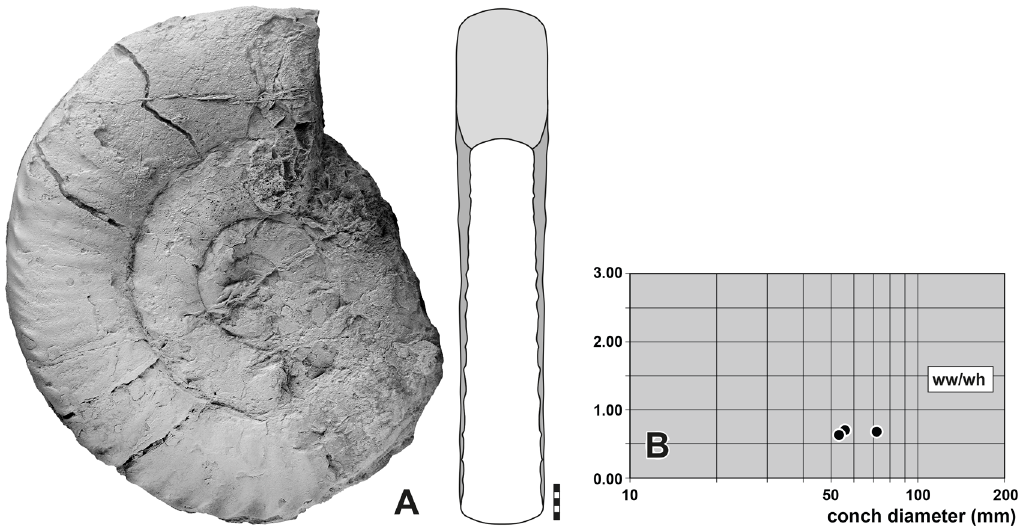
Fig. 62. Stoyanowites aspinosus Korn & Ghaderi, 2016. A . Lateral and dorsal view,